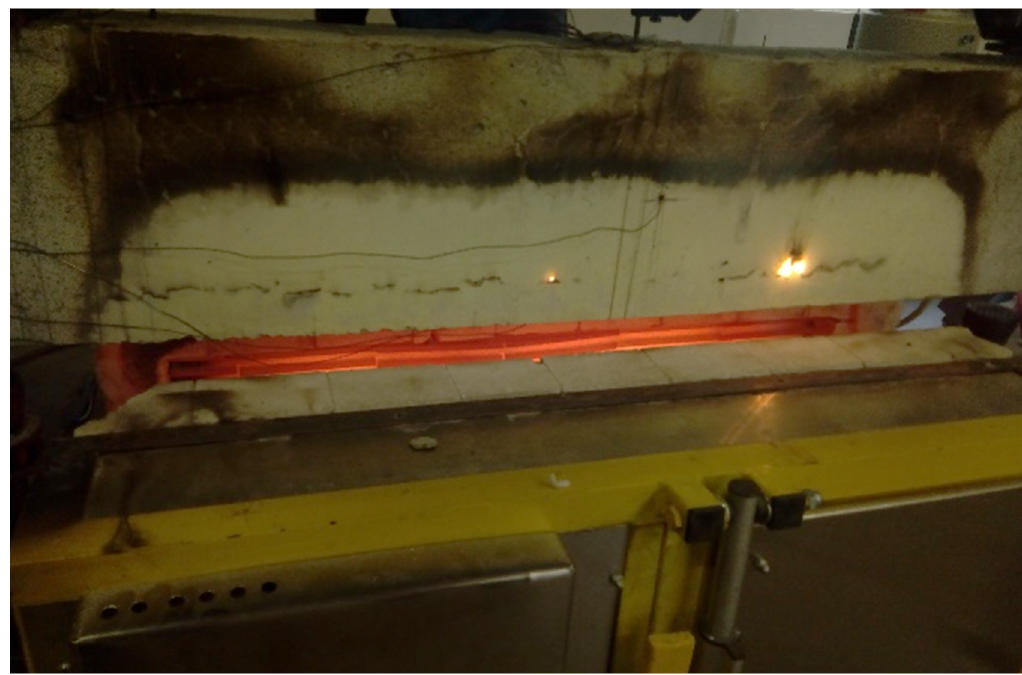
Figure 5. Sample B2Ø14 just after being taken out of the furnace.